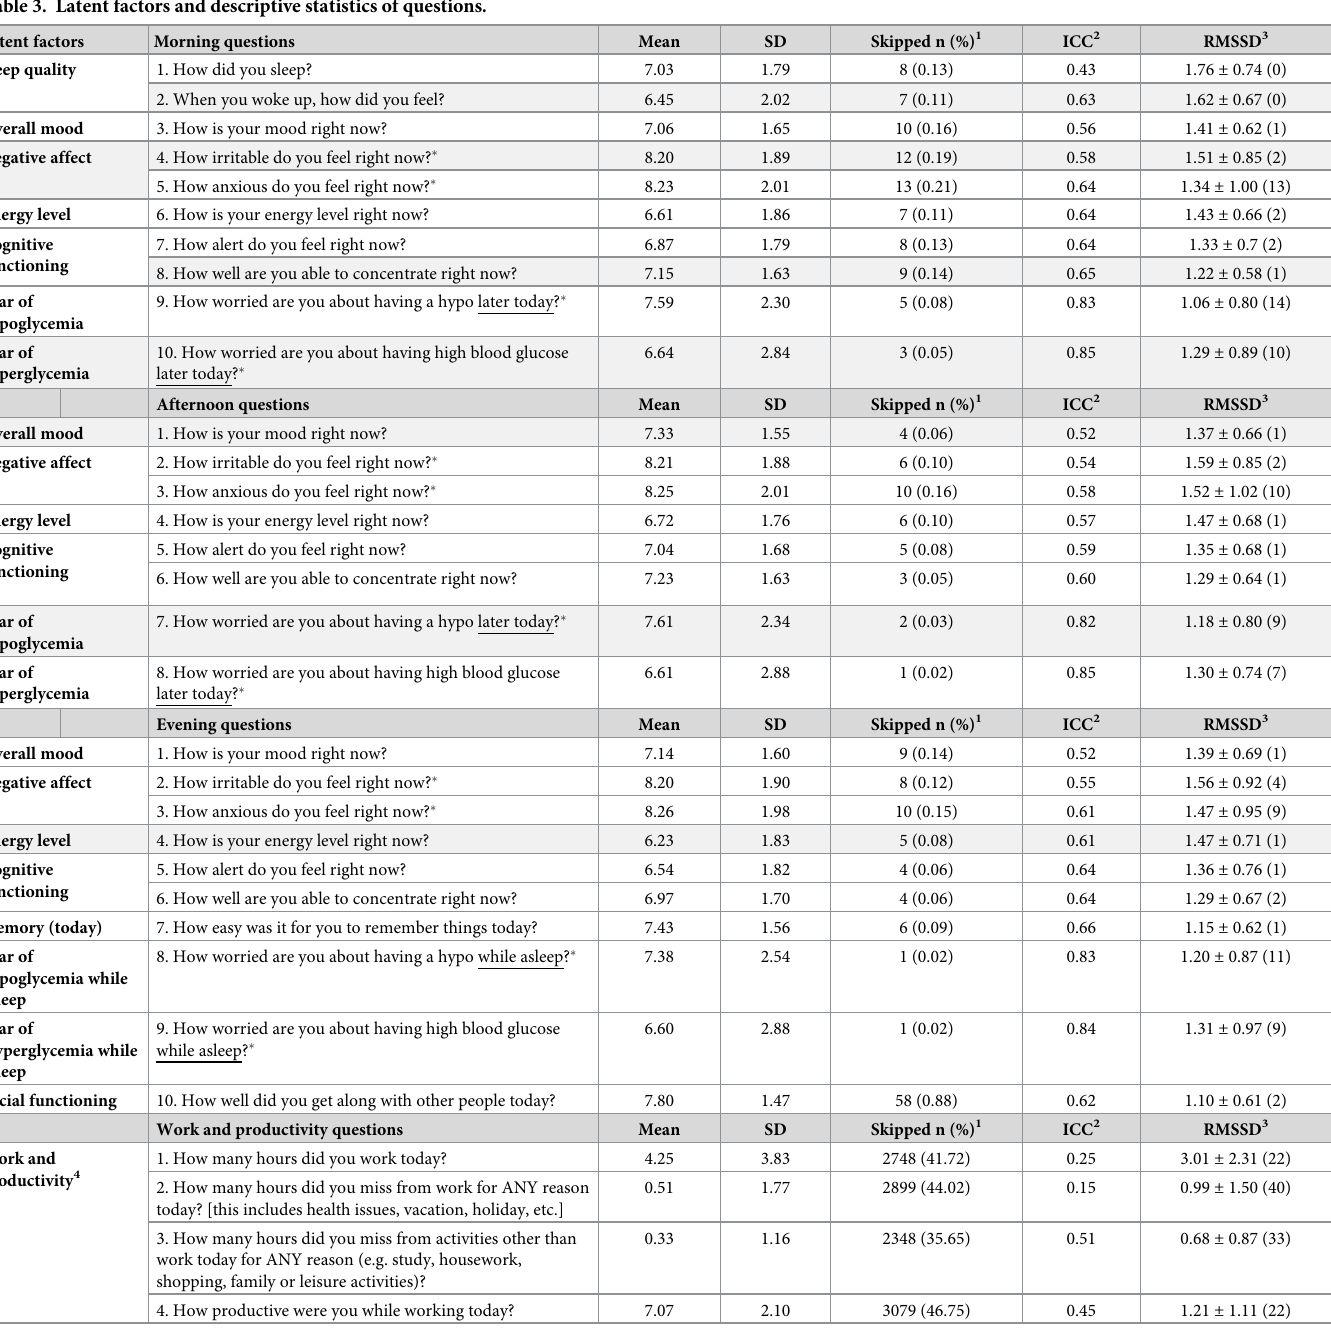
Table 3. Latent factors and descriptive statistics of